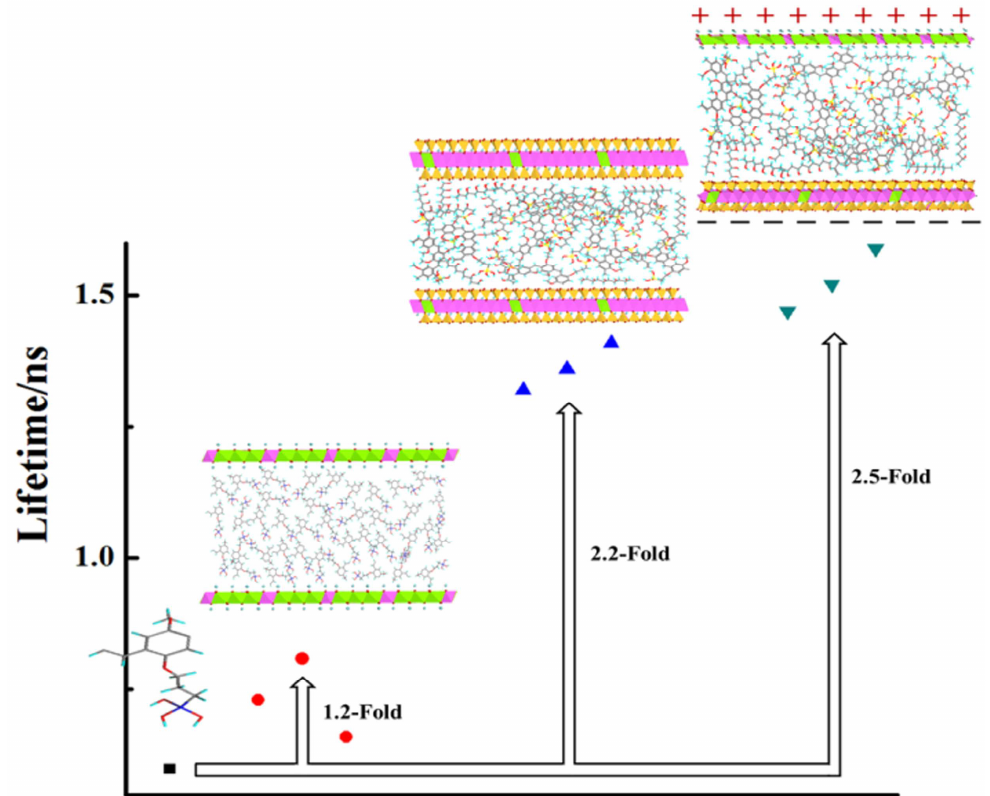
Figure 4. The comparison of APPV’s lifetimes in the different states under the different environments. The black, red, blue and bottle green dots represent the lifetime of APPV, LA( n )-films, MA( n )-films and MALA( n )-films, respectively. The folds stand for the different kinds of multilayer films’ luminescent lifetimes compared with the pristine APPV solution.